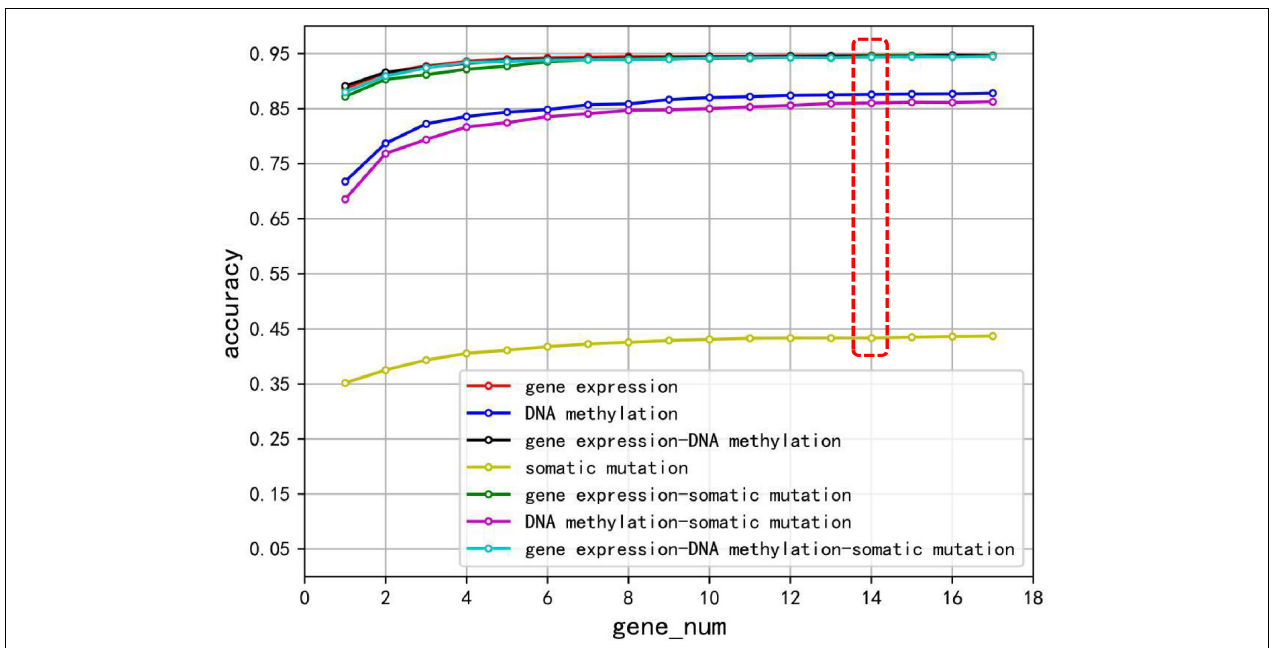
FIGURE 2 | The classification accuracy of using gene expression, somatic mutation, DNA methylation, and combination of the three biomarkers, respectively, on each gene set.